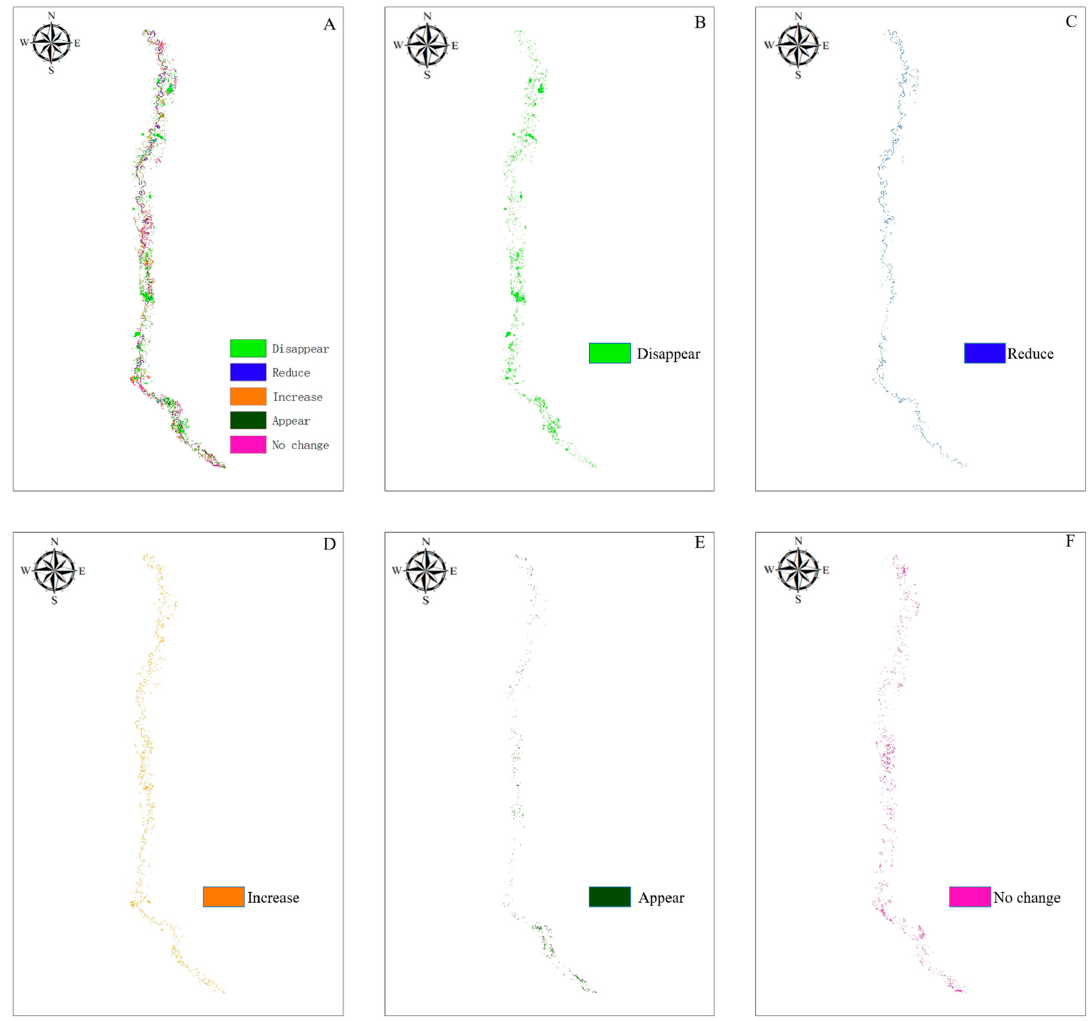
Figure 11. Transformation of the WIGR areas before and after dam construction. (This figure shows the change in WIGR before and after the construction of the water conservancy project, namely: ( A ): the change in the overall WIGR before and after the construction of the water conservancy project; ( B ): Indicates the area where WIGR values disappear before and after construction; ( C ): Indicates the area where the WIGR value decreases before and after construction; ( D ): Indicates the area where WIGR value increases before and after construction; ( E ): Indicates the area where WIGR values appear before and after construction; ( F ): It refers to the area where the WIGR value has no change before and after construction).